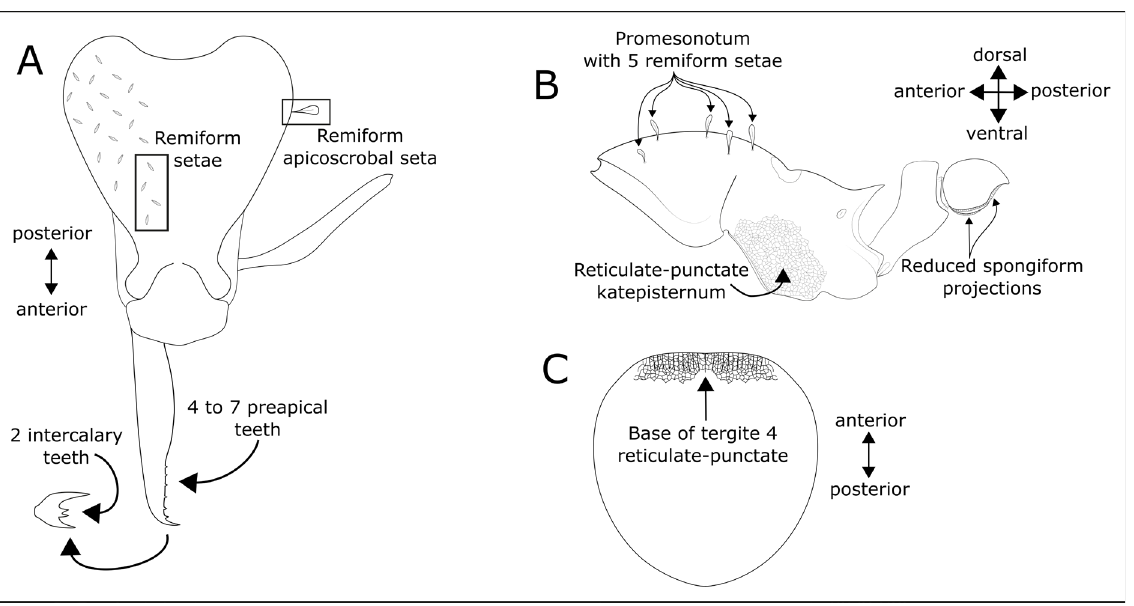
Fig. 8. Generalized schematics of Strumigenys subedentata Mayr, 1887, showing useful identification features. A . Head in dorsal view. B . Mesosoma, petiole, and postpetiole, in lateral view. C . Fourth abdominal tergite in dorsal